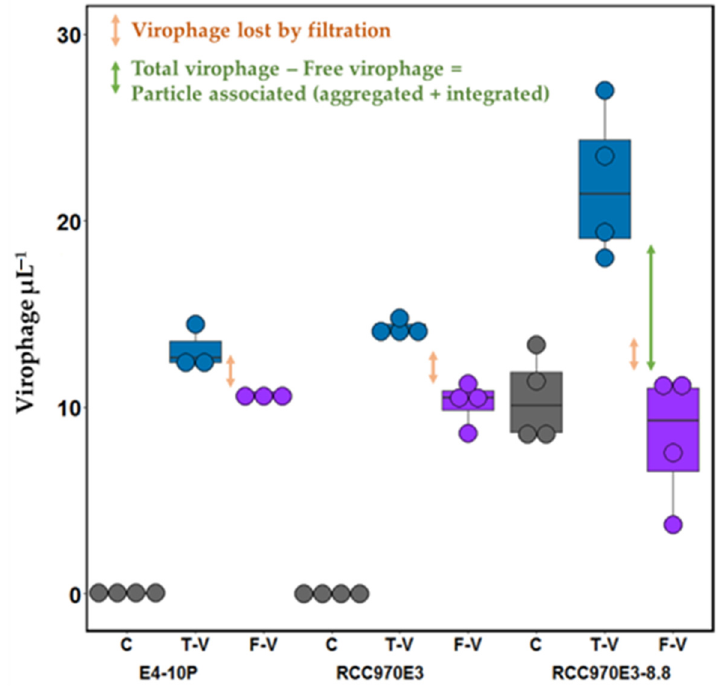
Figure 5. Virophage ddPCR-based quantification. Shown are copy number concentrations (virophage µL − 1 ; median, 4 replicates) for host strains without integrated virophage (E4-10P, RCC970E3) and with integrated virophage (RCC970E3-8.8). Control (C; grey): host strain with no virophage added, no filtration before DNA extraction; Total-Virophage (T-V, blue): host and virophage, no filtration before DNA extraction; Free-Virophage (F-V, purple): filtered sample of host and virophage before DNA extraction.